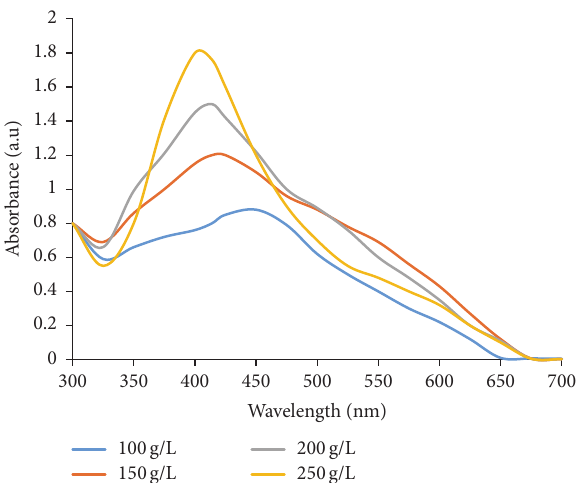
Figure 6: UV-Vis spectra of WMRE-AgNPs showing the effect of variation of WMRE concentration on WMRE-AgNPs synthesis.